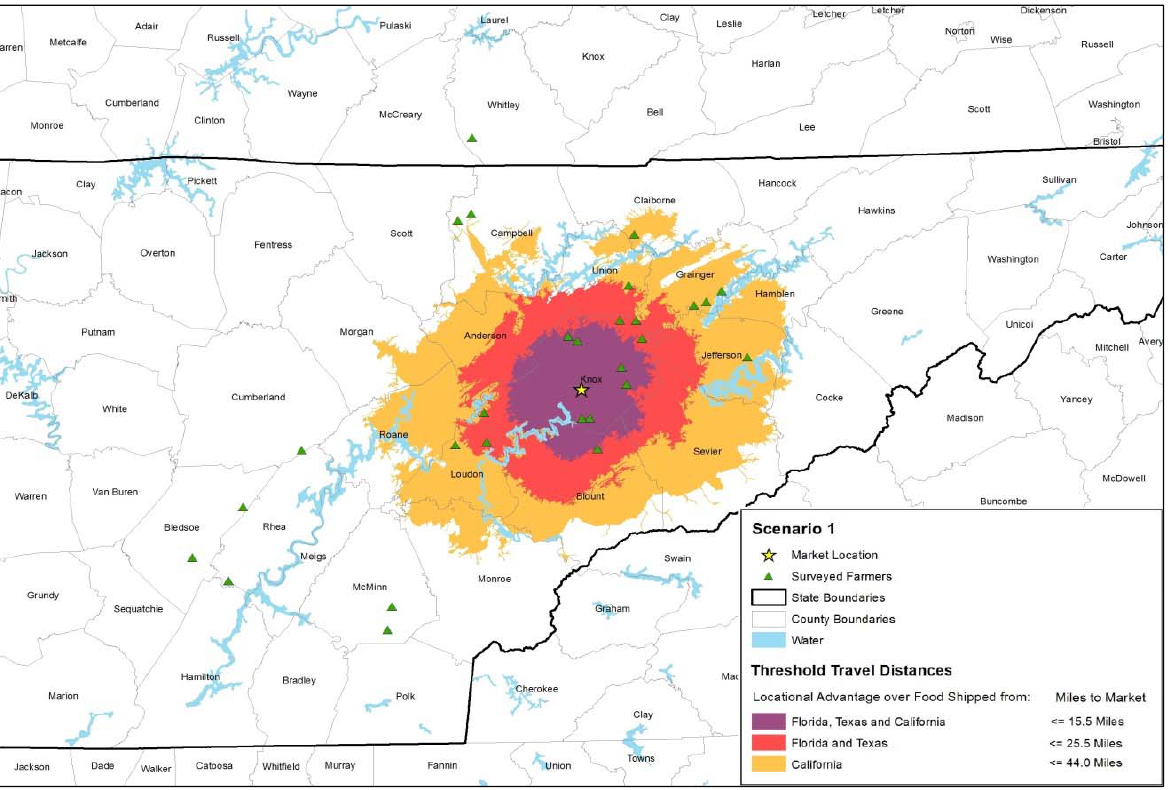
Figure 4. Scenario 1 Competitive Transportation Zones Scenario 1 models the average local farmer with 2.25 acres (0.91 ha) planted in fruits and vegetables and a pickup truck for transportation (see Table 3 for scenario